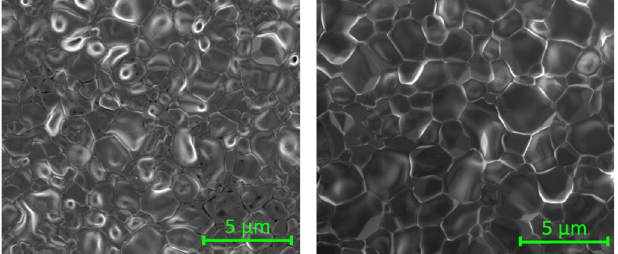
FIG. 6. SEM images of witness samples coated using prepa- rations A (left) and B